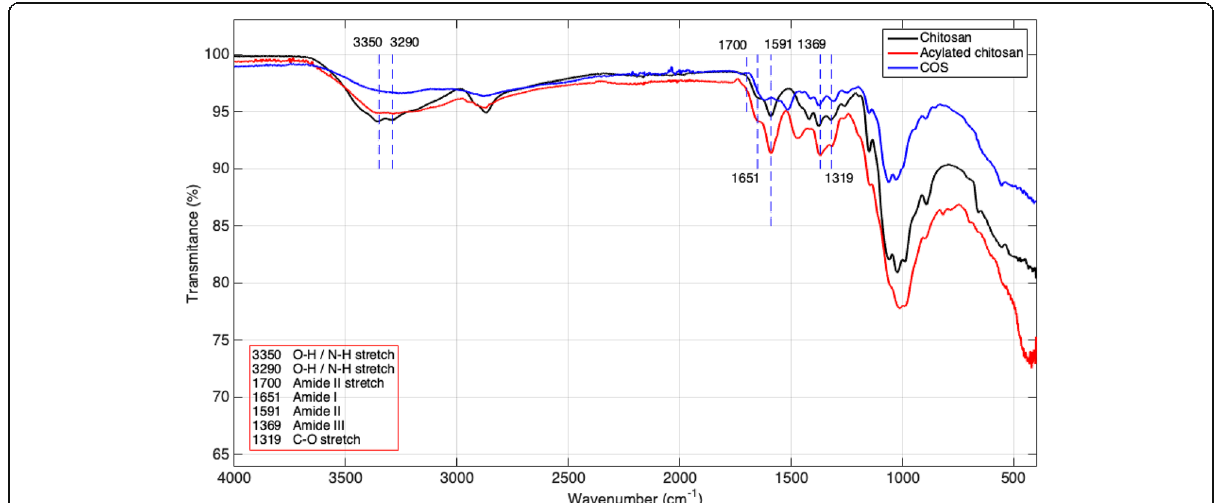
Fig. 5 FT-IR spectra of chitosan, acyl-chitosan, and chitosan oligosaccharide. Band at 1591 cm − 1 corresponds to secondary amides; 3200 – 3500 cm − 11 regions correspond to N-H and O-H vibrations